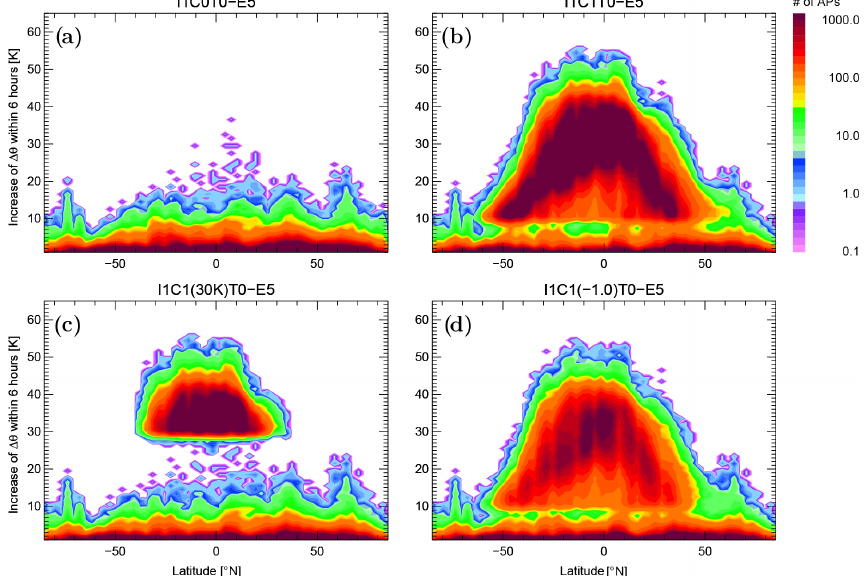
Figure 7. Total number of APs lifted upwards (units: total number per lat/theta grid size and time step) in different E5-driven configura- tions averaged over the first 10d of January 2017. (a) Run without any convective parameterization. (b) Run with the parameterization of unresolved convection and with the best agreement with experimental data. (c, d) Two sensitivity studies for unresolved convection with (cid:49)θ c > 30K (instead of (cid:49)θ c > 10K, a, c ) and for N 2 m = − 1 . 0 × 10 − 4 1s − 2 (instead of N 2 m = 01s − 2 , right).